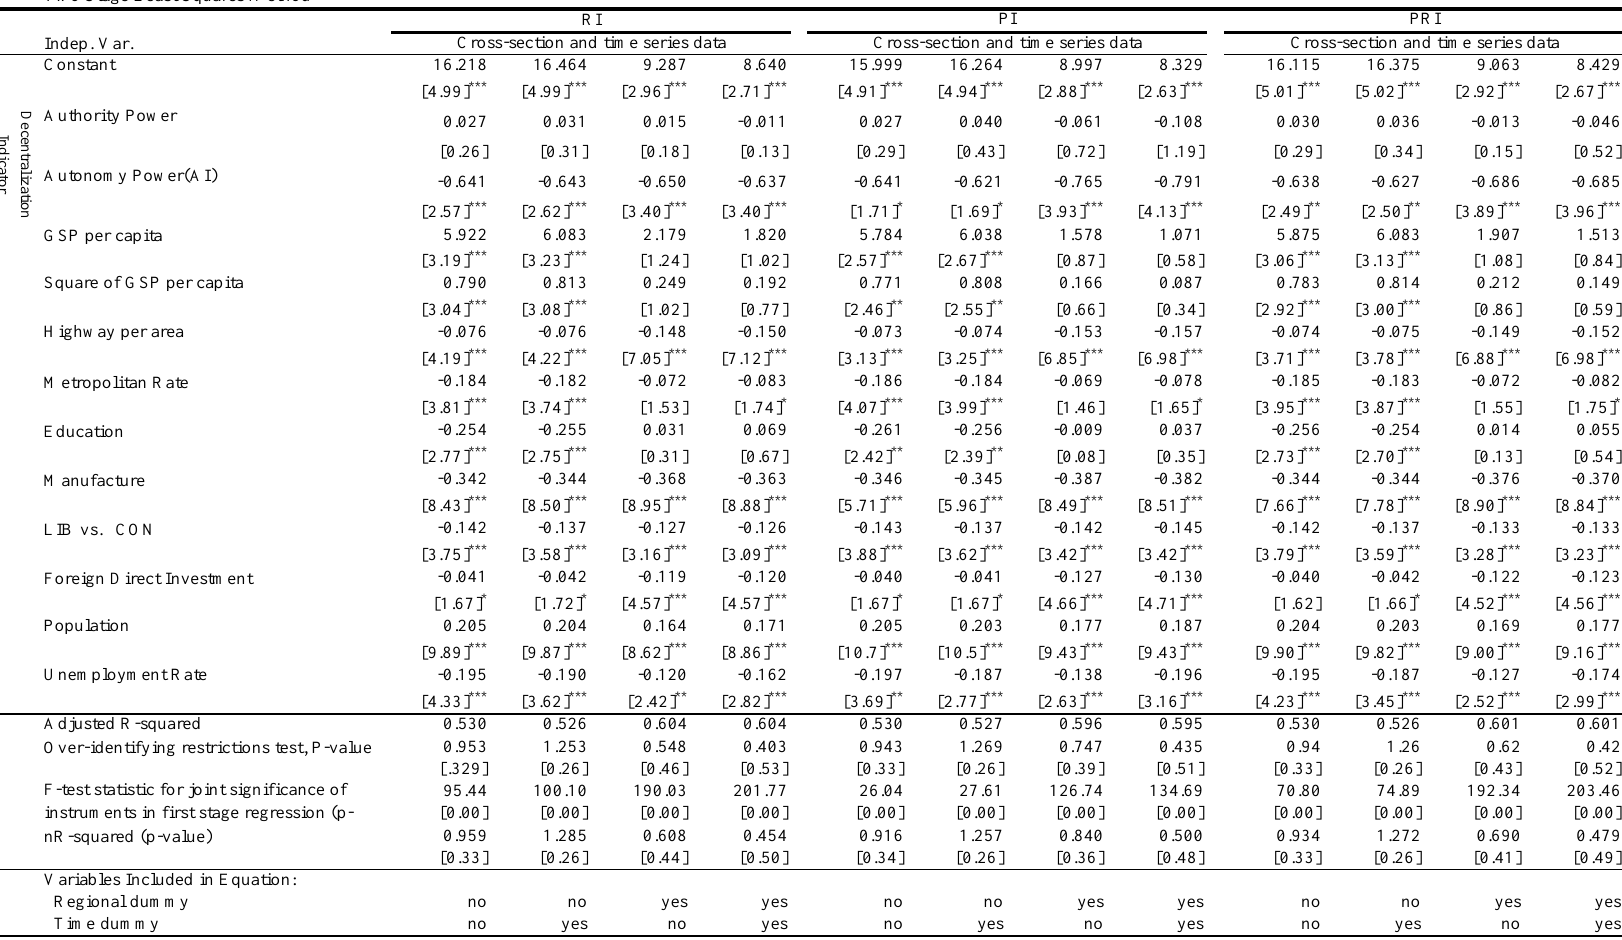
Table 3: Estimation Results (Inequality = GINI Coefficient) Method =